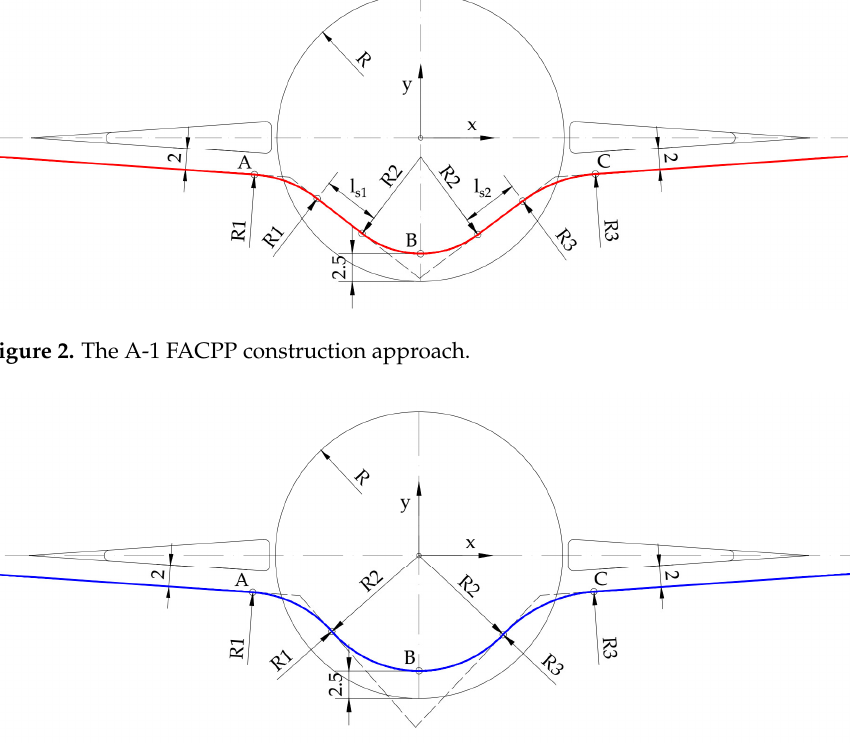
Figure 3. The A-2 FACPP construction approach.